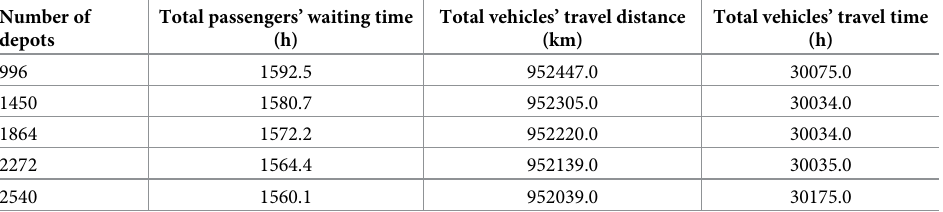
Table 4. Simulation results for different number of depots.